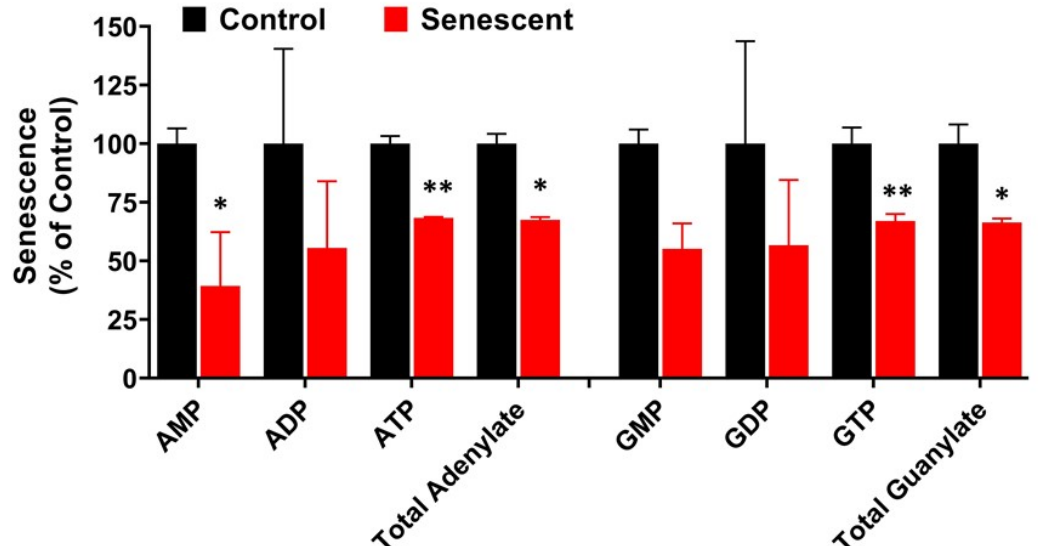
Figure 4. Levels of energy charge adenylate and guanylate in control and senescent HCT-116 cells. Metabolites in senescent cells are expressed as percent of control based on protein concentration of samples. Results are ± SD of triplicate samples. * p value < 0.05; ** p value < 0.01. Actual values obtained from analysis (nmoles/g protein) including p values and significance is presented in Table S2.